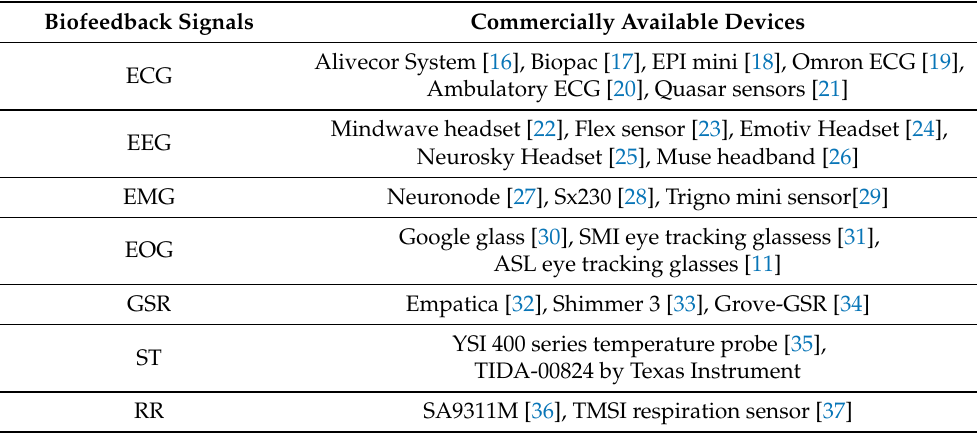
Table 1. Commercially available psychophysiological signal measuring